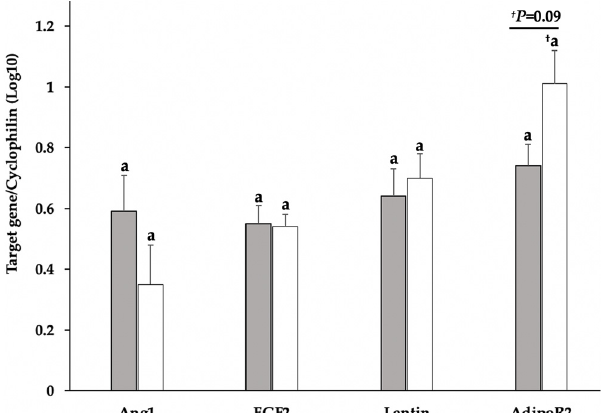
Figure 3. Gene expression of Ang1, FGF2, leptin, and AdipoR2 in luteal tissue from sows on D5 (shaded bars; n = 4) and D7 (open bars; n = 5) of the estrous cycle. Relative quantities of amplicons were transformed to log 10 and normalized with cyclophillin. a Superscript identifies means that did not statistically differ ( a p > 0.05). † Superscript identify means that tended ( † p = 0.09) to differ relative to day.